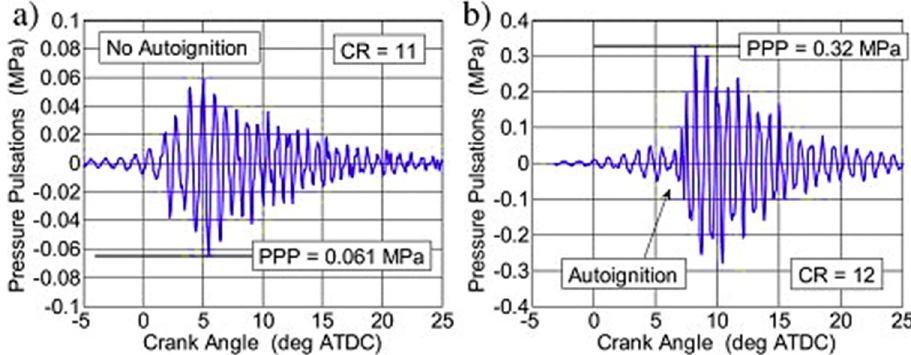
Figure 3. Comparison between weak knock and strong knock (Szwaja and Naber [61]). ( a ) the pressure pulsations start at 0 ◦ . ( b ) indicates pressure pulsation condition during combustion at CR =